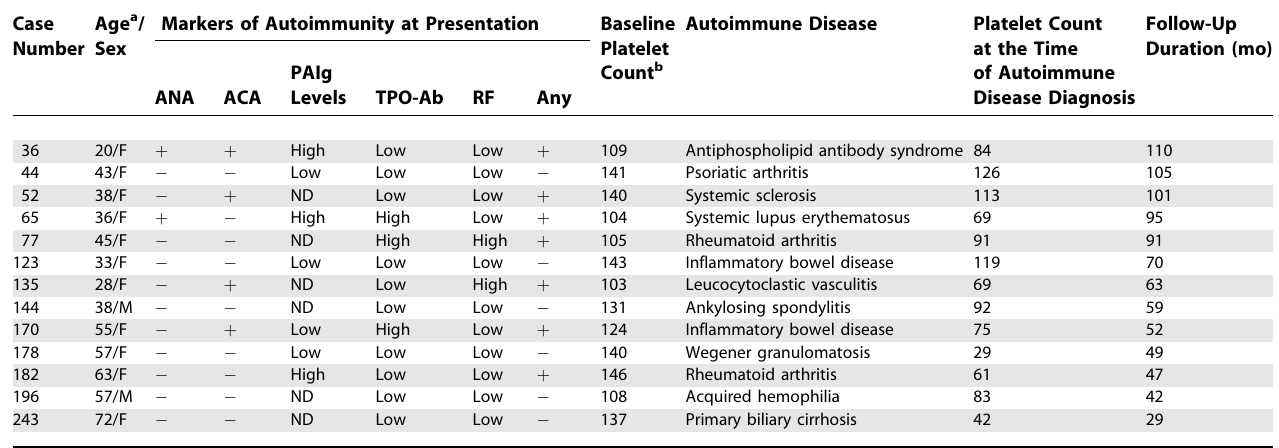
Table 5. Clinical and Laboratory Characteristics of the 13 Individuals Who Developed an Autoimmune Disease during Follow-Up Case Age a / Markers of Autoimmunity at Number Sex